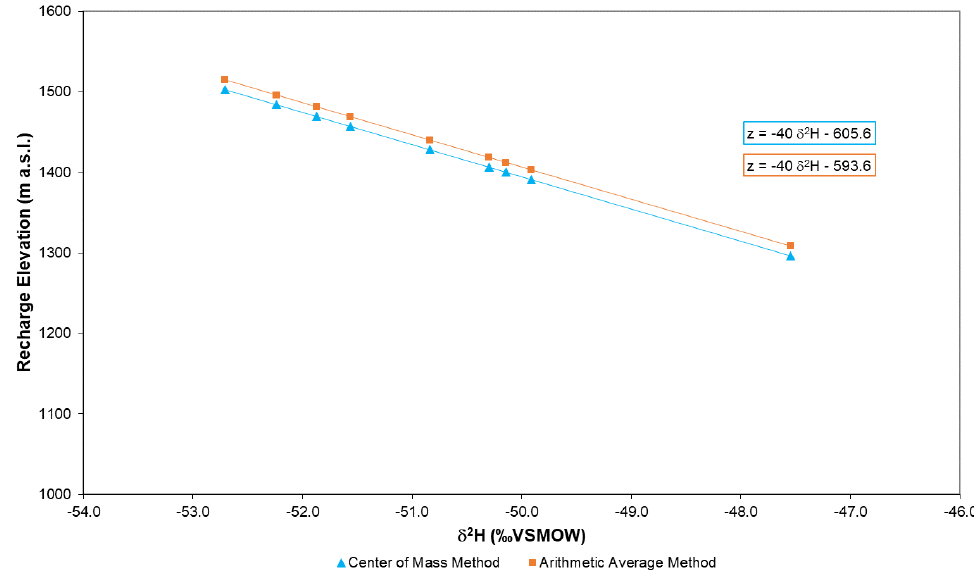
Figure 5. δ 18 O values of spring samples plotted against recharge elevations (October 2002).